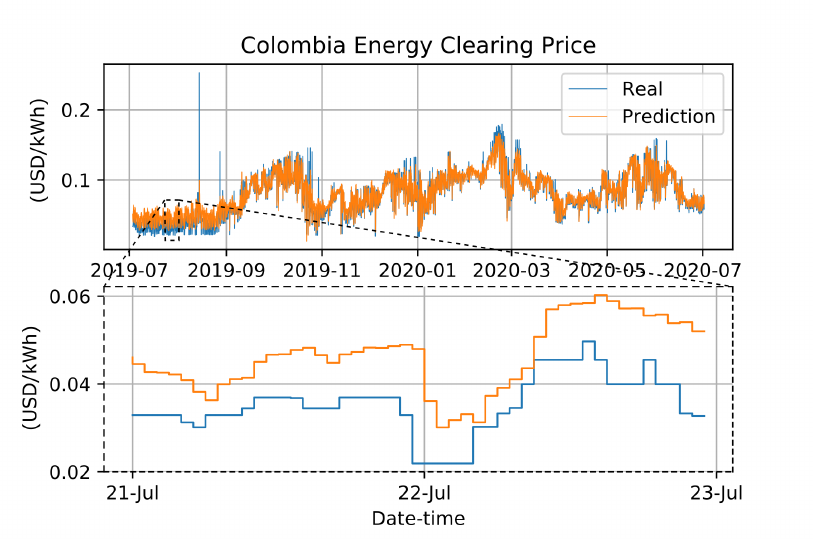
Figure 6. Results of the price forecasting model throughout the simulation